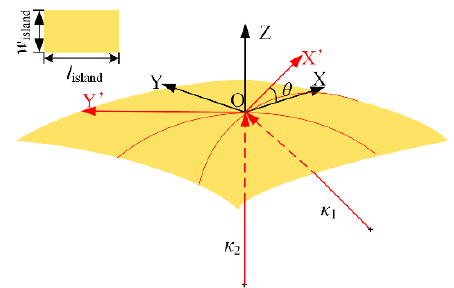
Figure A1. The schematic for island on surface with initial angle θ .